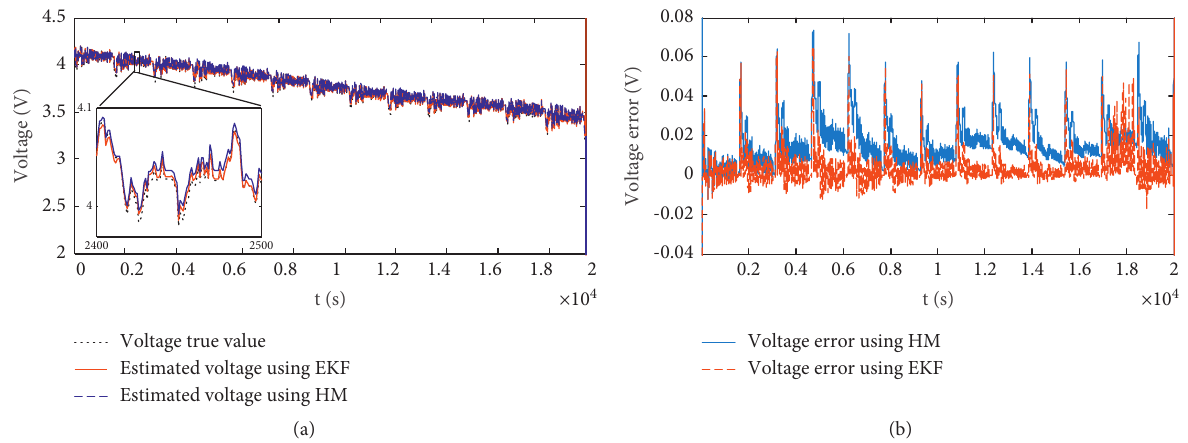
Figure 4: Estimated voltage results and their errors. (a) The estimated voltage. (b) The estimated voltage errors.